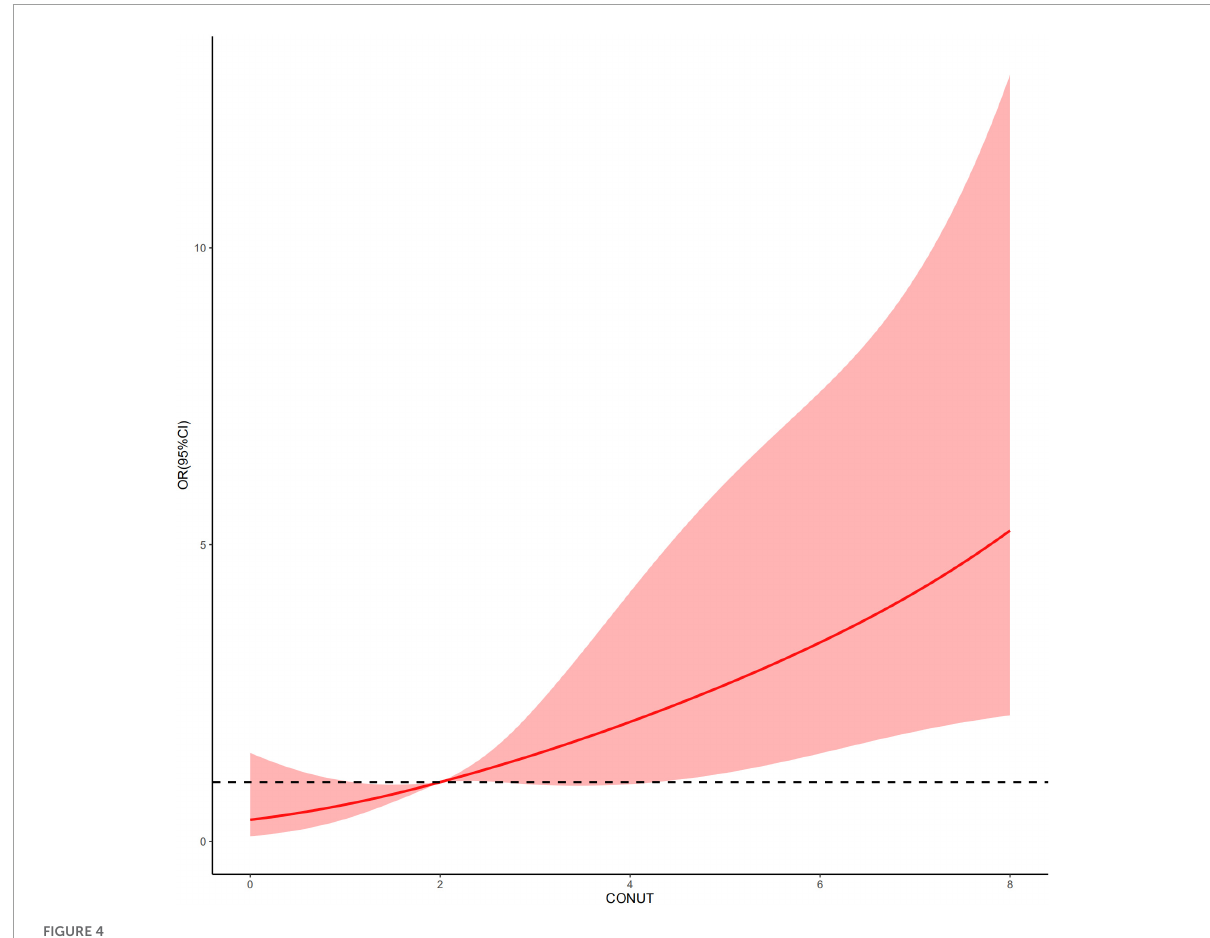
FIGURE4 Restrictive cubic spline based on multivariable logistic regression